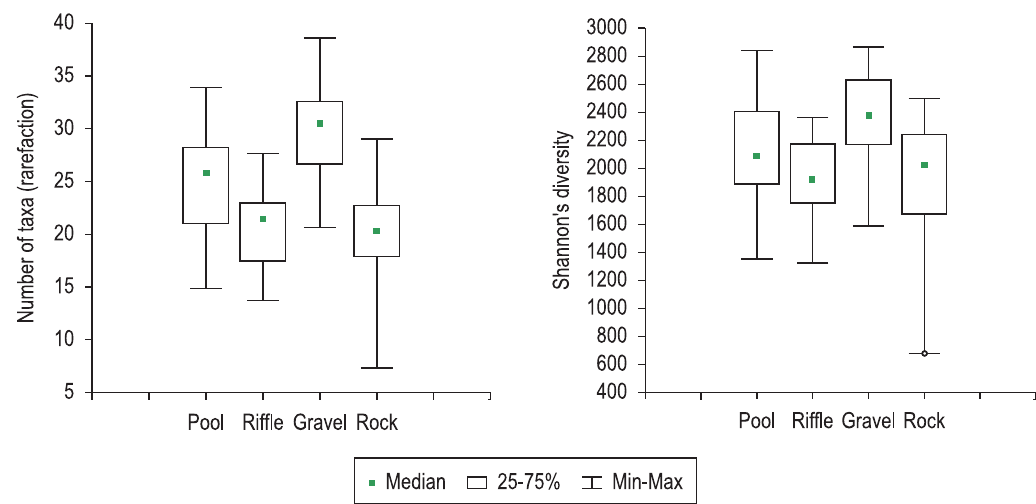
Figure 2. Mean (Min-Max) rarefaction and Shannon’s Diversity found to substrates studied in the streams at Serra da